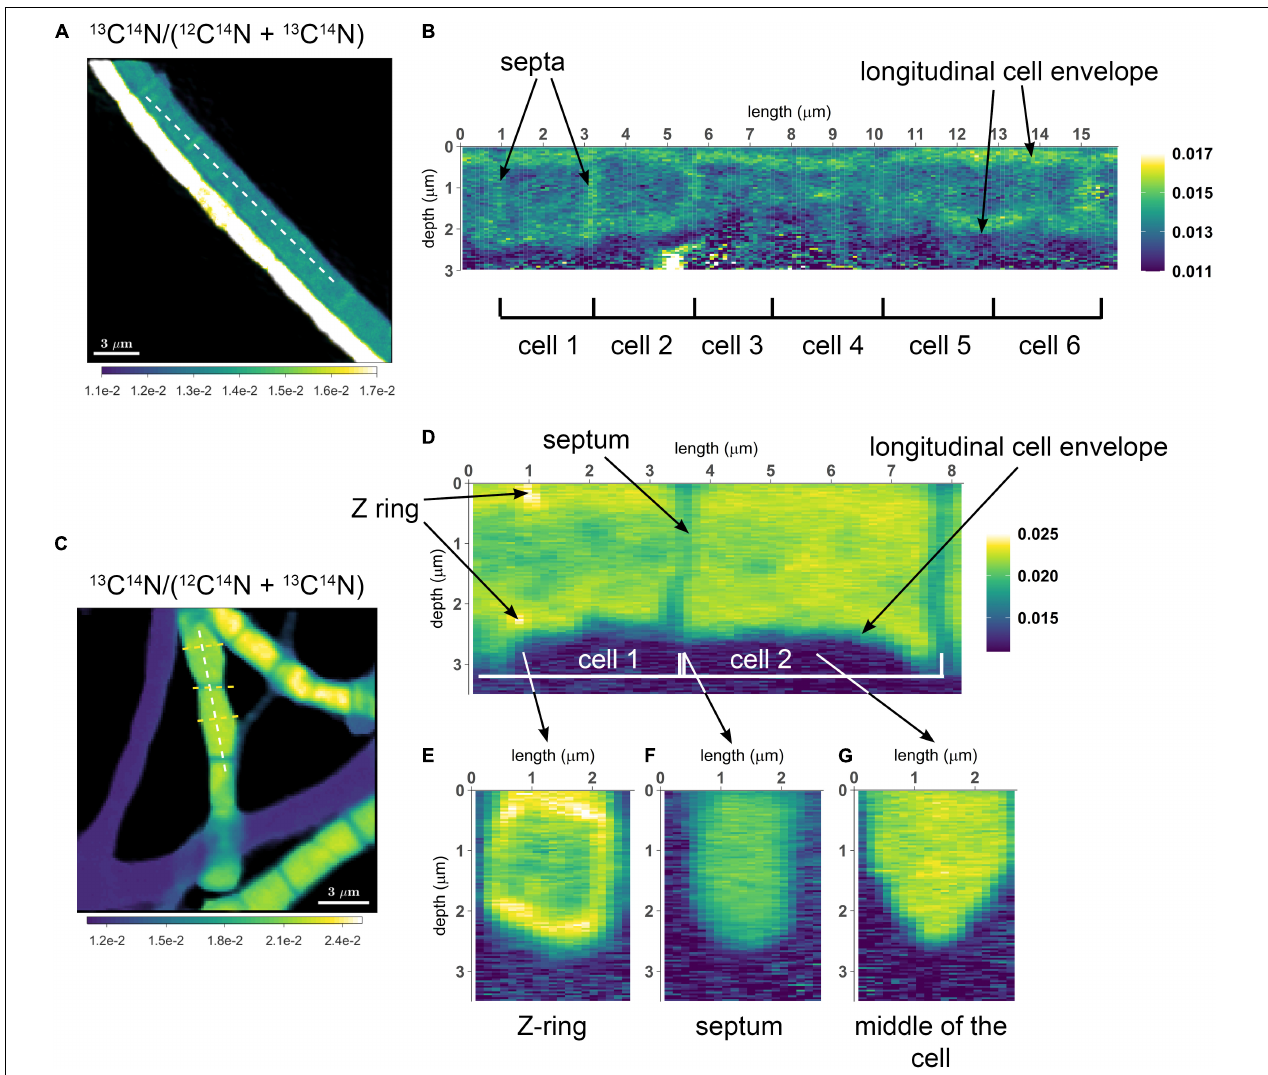
FIGURE 2 | NanoSIMS images of cable bacterium filaments retrieved from the suboxic zone of the sediment. All images show the 13 C atom fraction, calculated from the secondary ion count as 13 C 14 N/( 12 C 14 N + 13 C 14 N). Measurements were performed on filaments retrieved from an incubation that was labeled with 13 C-bicarbonate for 6 h. (A) NanoSIMS image of two parallel filaments. The bottom filament is more strongly 13 C labeled compared to the top filament. (B) A longitudinal cross section was analyzed over the length of six consecutive cells in the weakly labeled top filament [dotted line in panel (A) ]. The image shows the 13 C atom fraction as a function of depth. In this filament, increased 13 C enrichment is observed in the cell envelope and cell junctions, whereas the cytoplasm shows a 13 C atom fraction similar to the natural level (0.011). (C) NanoSIMS image of the 13 C atom fraction showing three filaments with stronger 13 C labeling (in addition to three filaments with no 13 C enrichment). (D) A longitudinal depth analysis [white dotted line in panel (C) ] shows the 13 C atom fraction with depth along the length of two adjacent cells. The cell envelope and junction show less 13 C enrichment than the cytoplasm. In cell 1, a ring with strong 13 C enrichment is observed (interpreted here as a Z-ring). A depth analysis across three transverse cross-sections was also performed [yellow dotted lines in panel (C) ]. (E) Transverse cross-section through the middle of a cell with a Z-ring. (F) Transverse cross-section through a cell-junction. (G) Transverse cross-section through the middle of a cell without a Z-ring. Here, the cytoplasm is more enriched in 13 C than the surrounding cell envelope. The color scale in panel (A,B) was adjusted to highlight the isotope enrichment in the cell envelope. The color scale in panel (E–G) is the same as in panel (C,D)